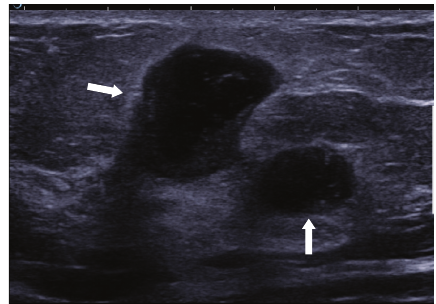
Figure 4: Multiple abscesses. Patient had multiple small abscesses on presentation. Two small abscesses located in close proximity are shown here.